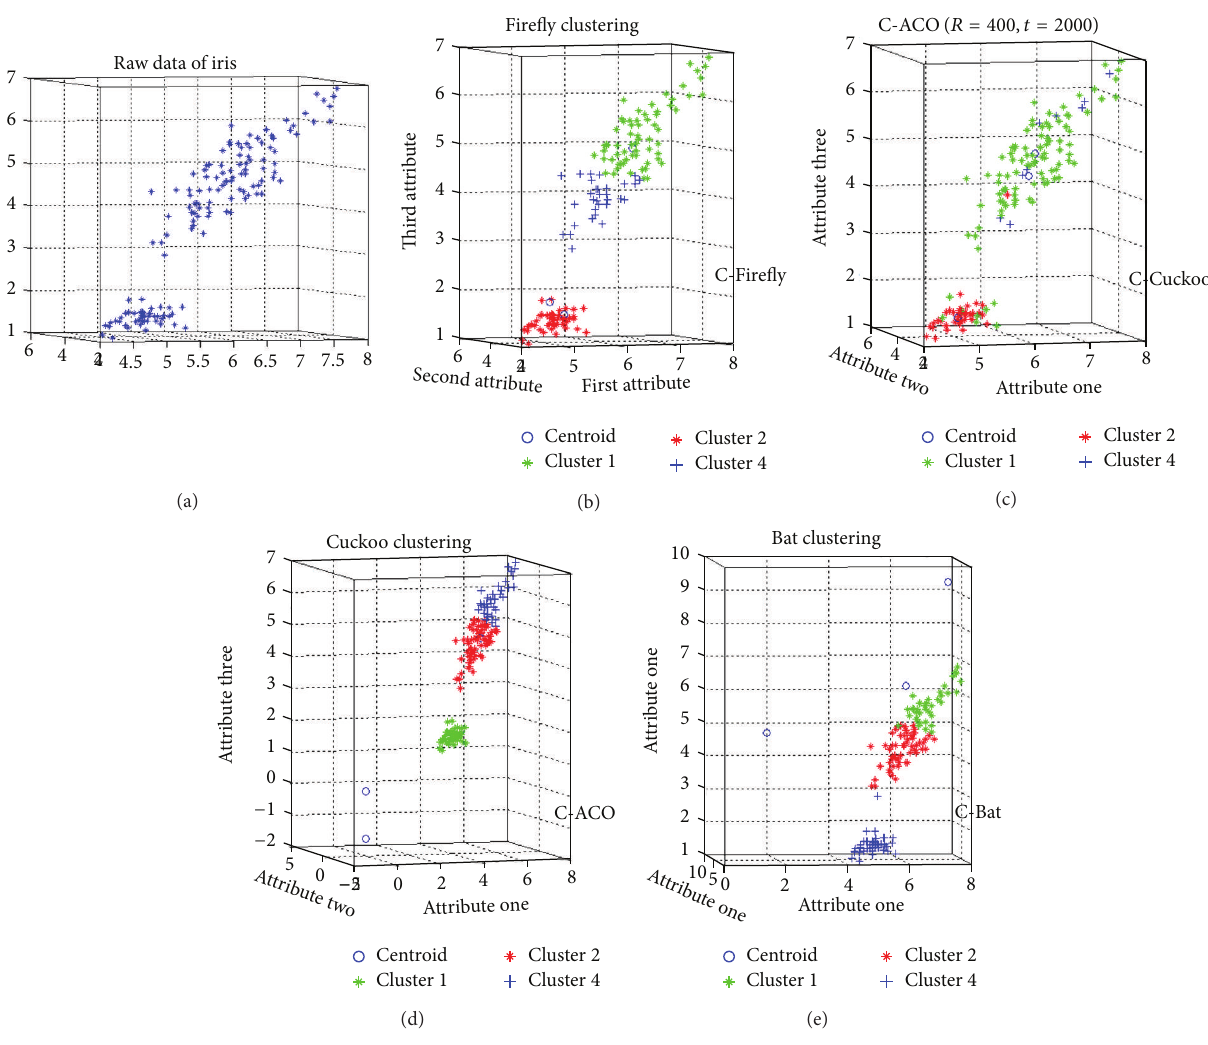
Figure 4: Snapshots of clustering